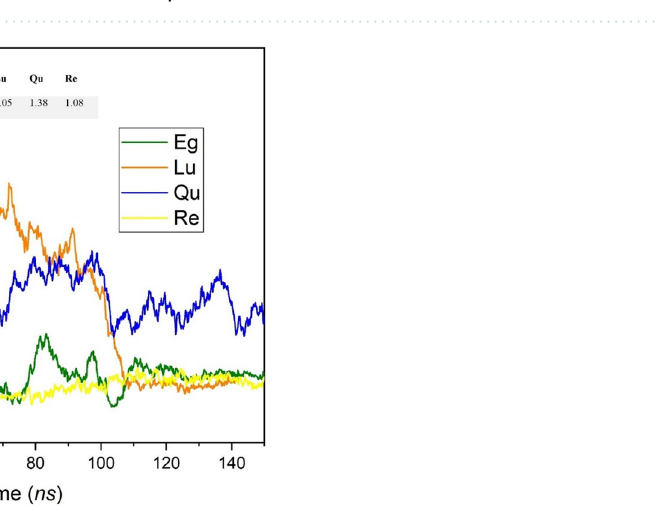
Figure 14. The density profiles for PP-PC complexes (at 0 ns and 150 ns), PP (at 150 ns), and PC (at 150 ns). ( A ) EG-PC, ( B ) Lu-PC, ( C ) Qu-PC, and ( D ) Re-PC systems.